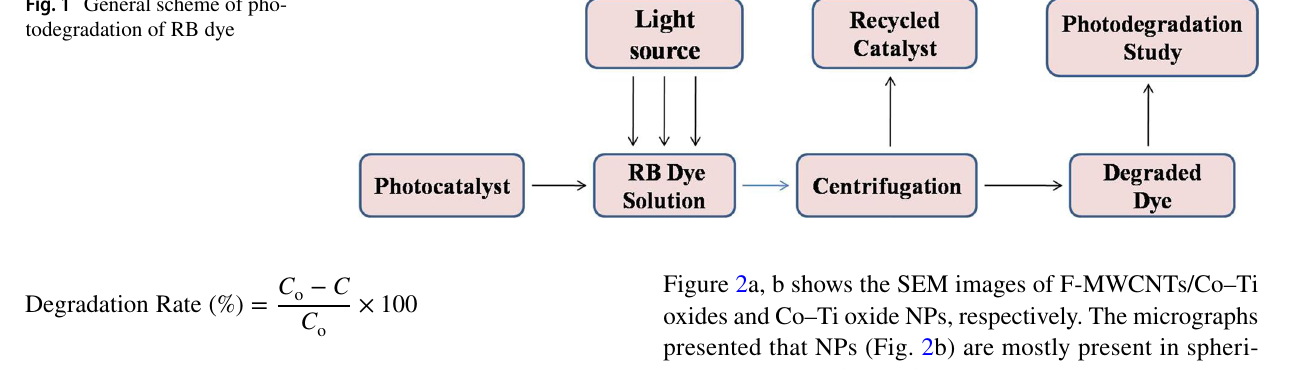
Fig. 1 General scheme of pho- todegradation of RB dye